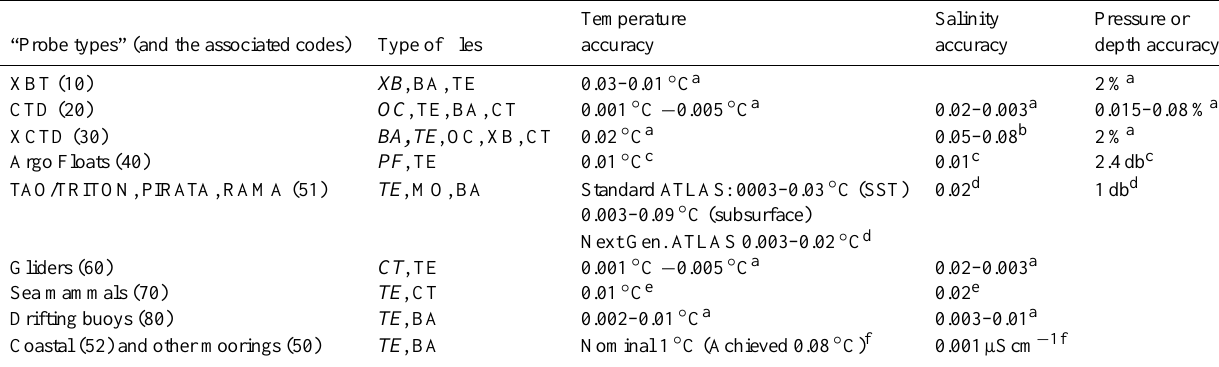
Table 1. Accuracies of the different data types included in CORA3. The type of netcdf files where each data type can be found is also listed (in italic for the most frequent occurrences). Note that data received from the GTS are not full resolution: data are truncated two places after the decimal point for the TESAC (TE) type and one place after the decimal point for the BATHY (BA)